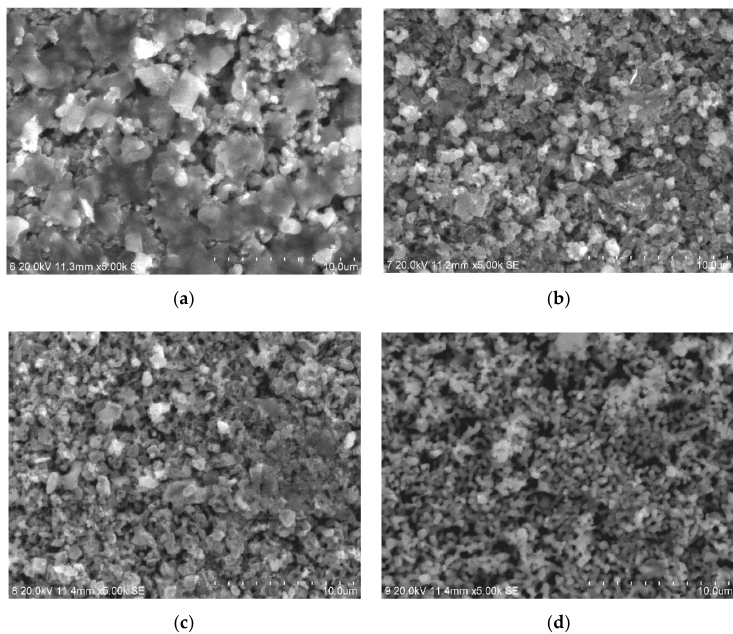
Figure 4. SEM micrographs of products electro-deoxidized in CaCl 2 –NaCl melt at different times. ( a ) 10 min; ( b ) 30 min; ( c ) 60 min; ( d ) 120 min. Table 1. Element content of product at different electrolysis time (%).